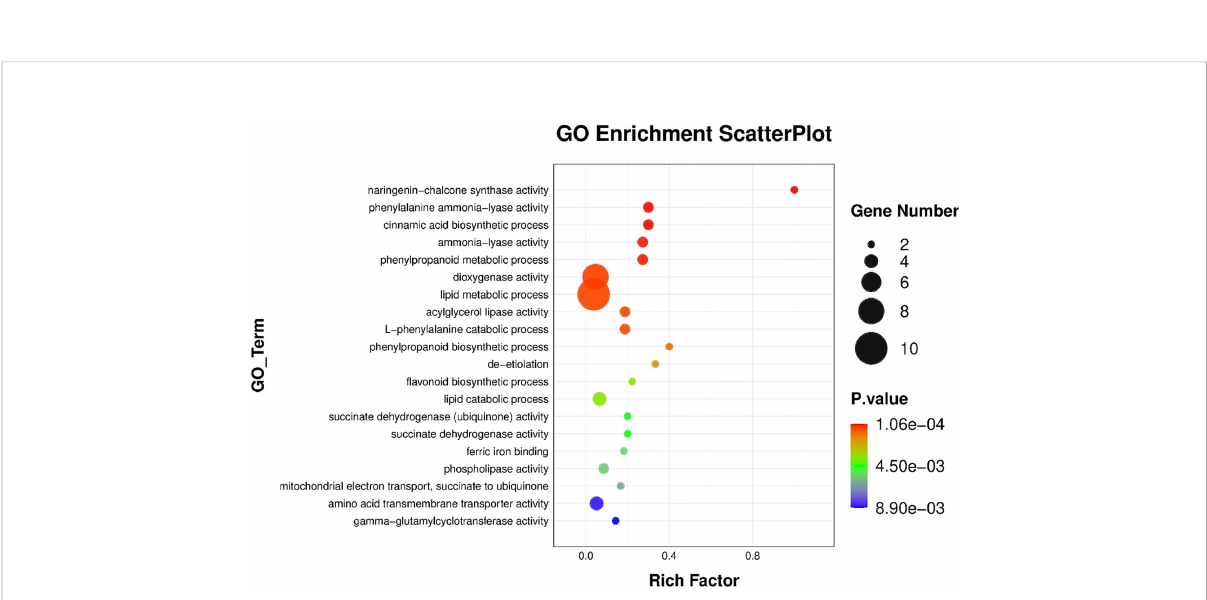
FIGURE 4 KEGG pathway enrichment scatter plot. The vertical axis represents the path name, and the horizontal axis represents the path factor corresponding to the rich factor.